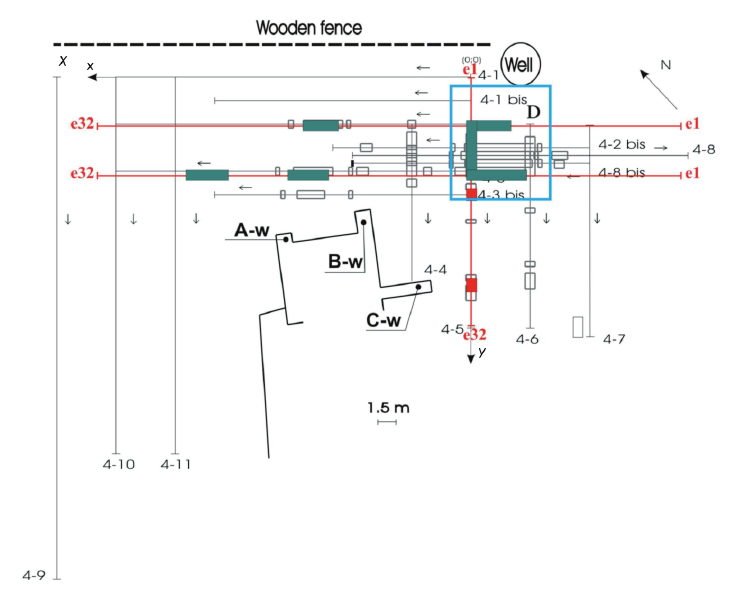
Fig. 8. Overlap between main GPR (gray) and geoelectrical anomalies.